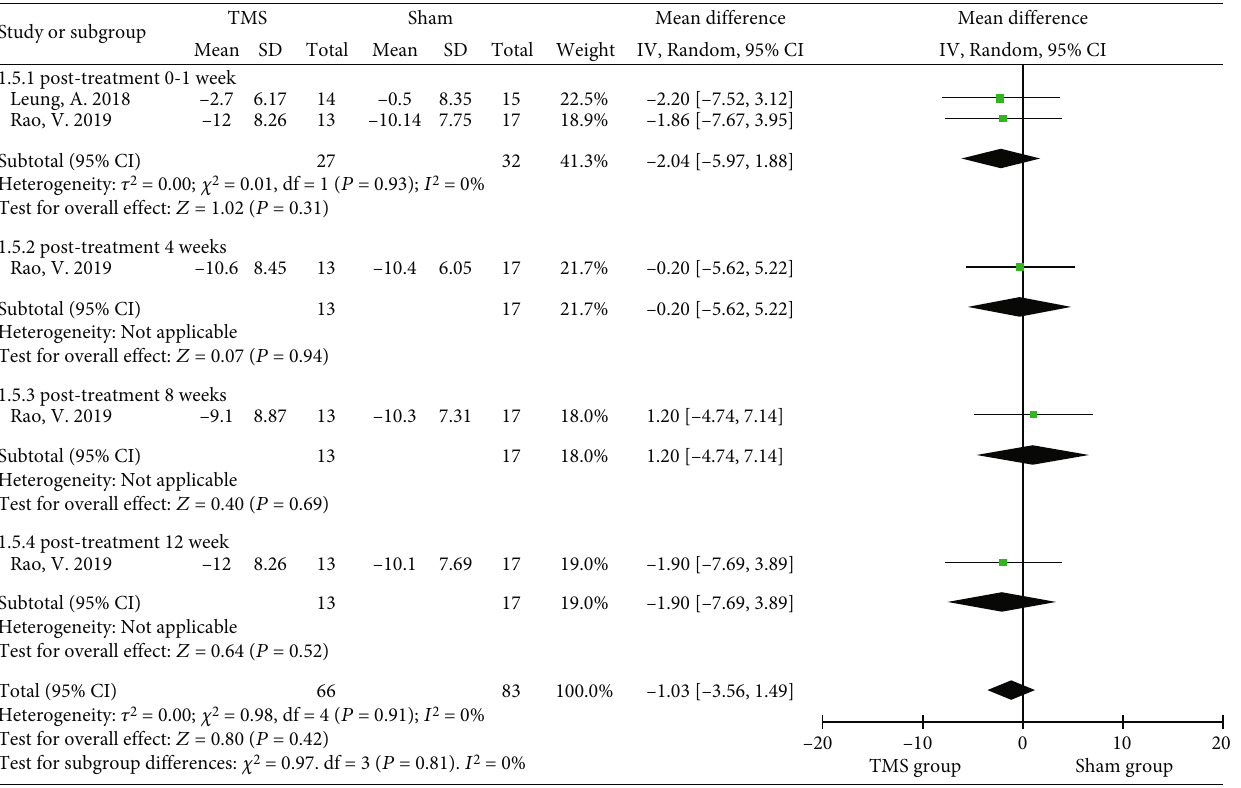
Figure 5: Forest plots of the e ff ect of rTMS on depression measured by the HRSD in TBI patients. HRSD: Hamilton Rating Scale for Depression.